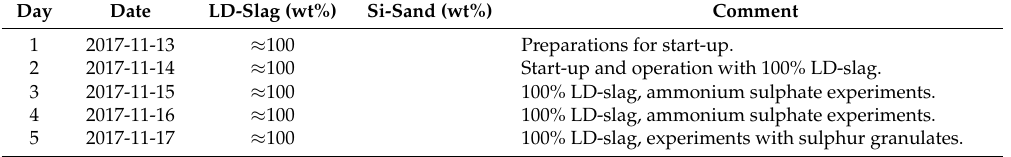
Table 4. Overview of the experimental campaign with the Chalmers Research Boiler. Day Date LD-Slag (wt%) Si-Sand (wt%)